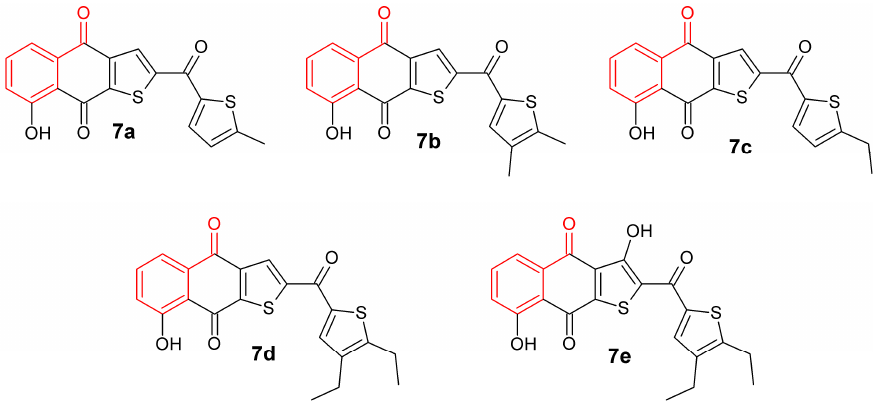
Figure 5. Chemical structure of the molecules designed according to comparative molecular field analysis (CoMFA) analysis.